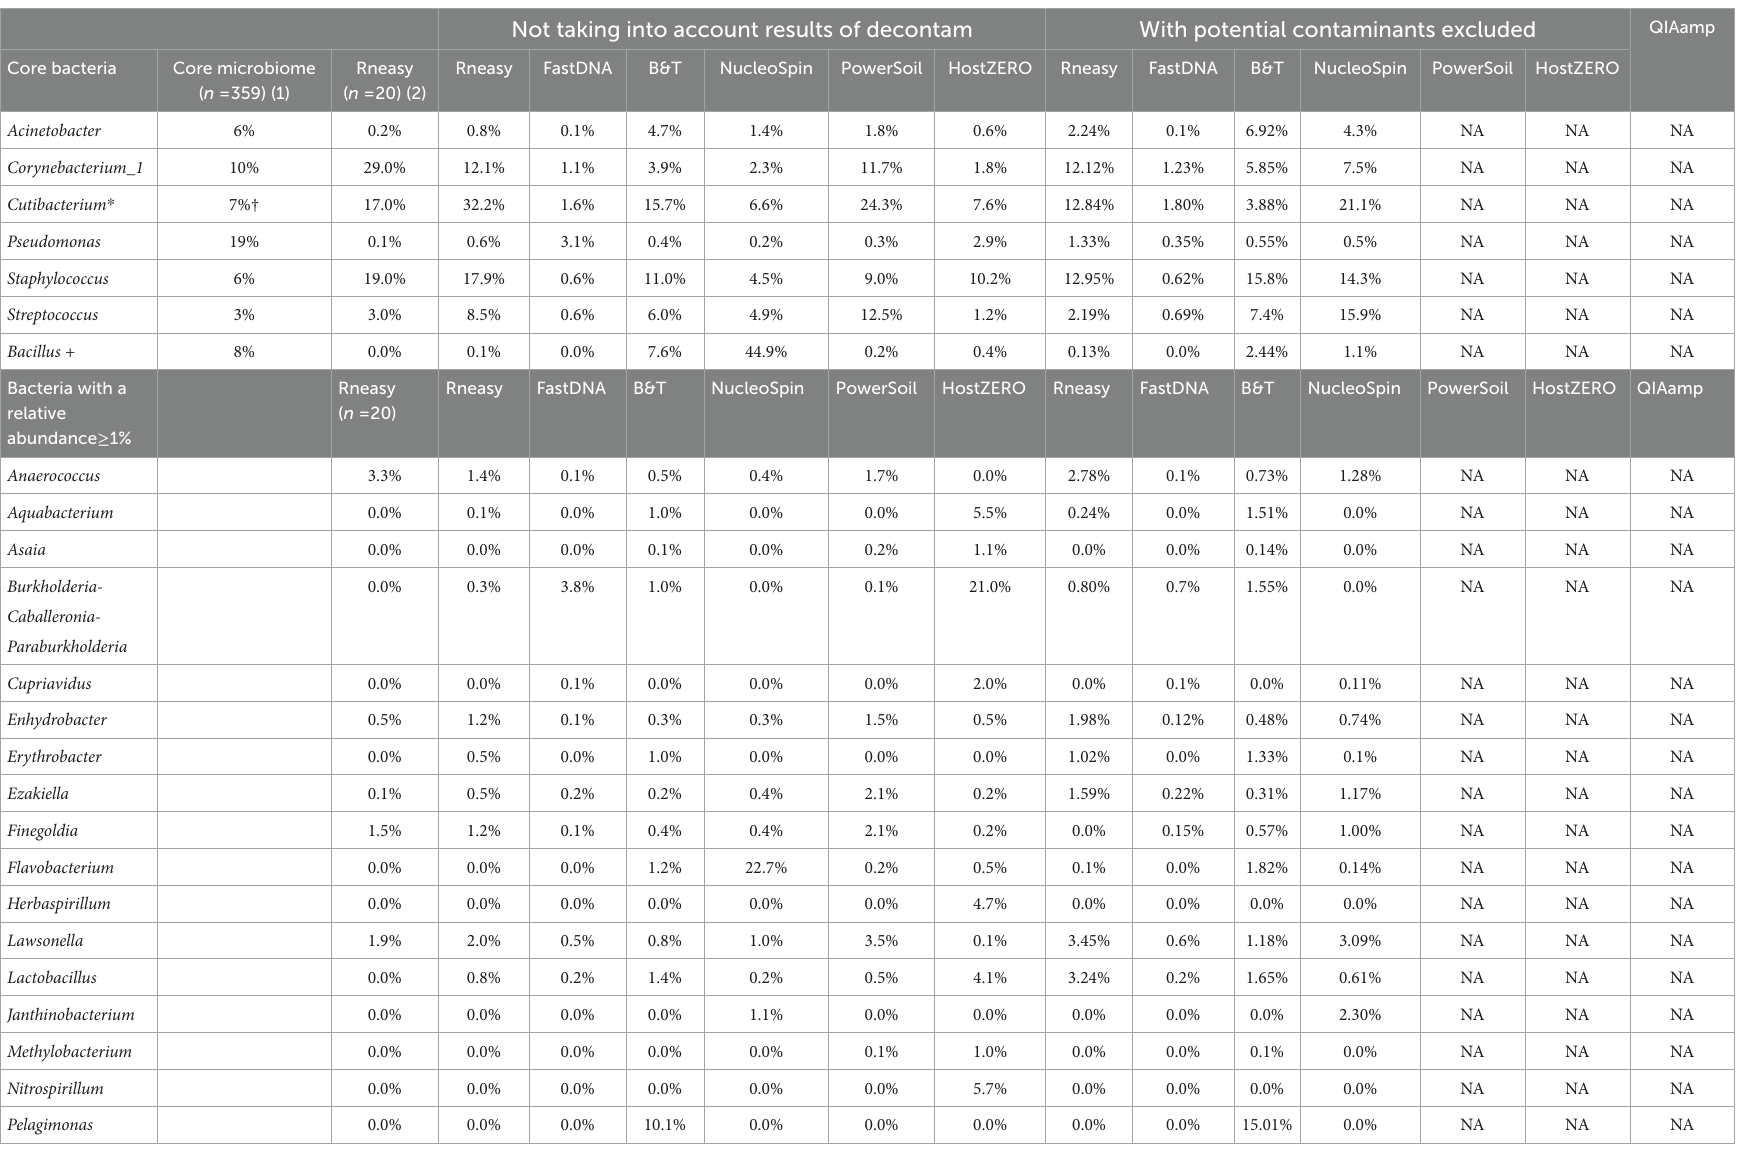
TABLE 5 Comparison of relative abundances ( ≥ 1%) of the core genera as described in our systematic review [combining different extraction protocols ( n = 359)] (Delbeke et al., 2021) (1), the healthy controls ( n = 20) from our previous publication analysed with RNeasy (Delbeke et al., 2022) (2) and the sequencing results of our current project per used extraction protocol with and without decontamination